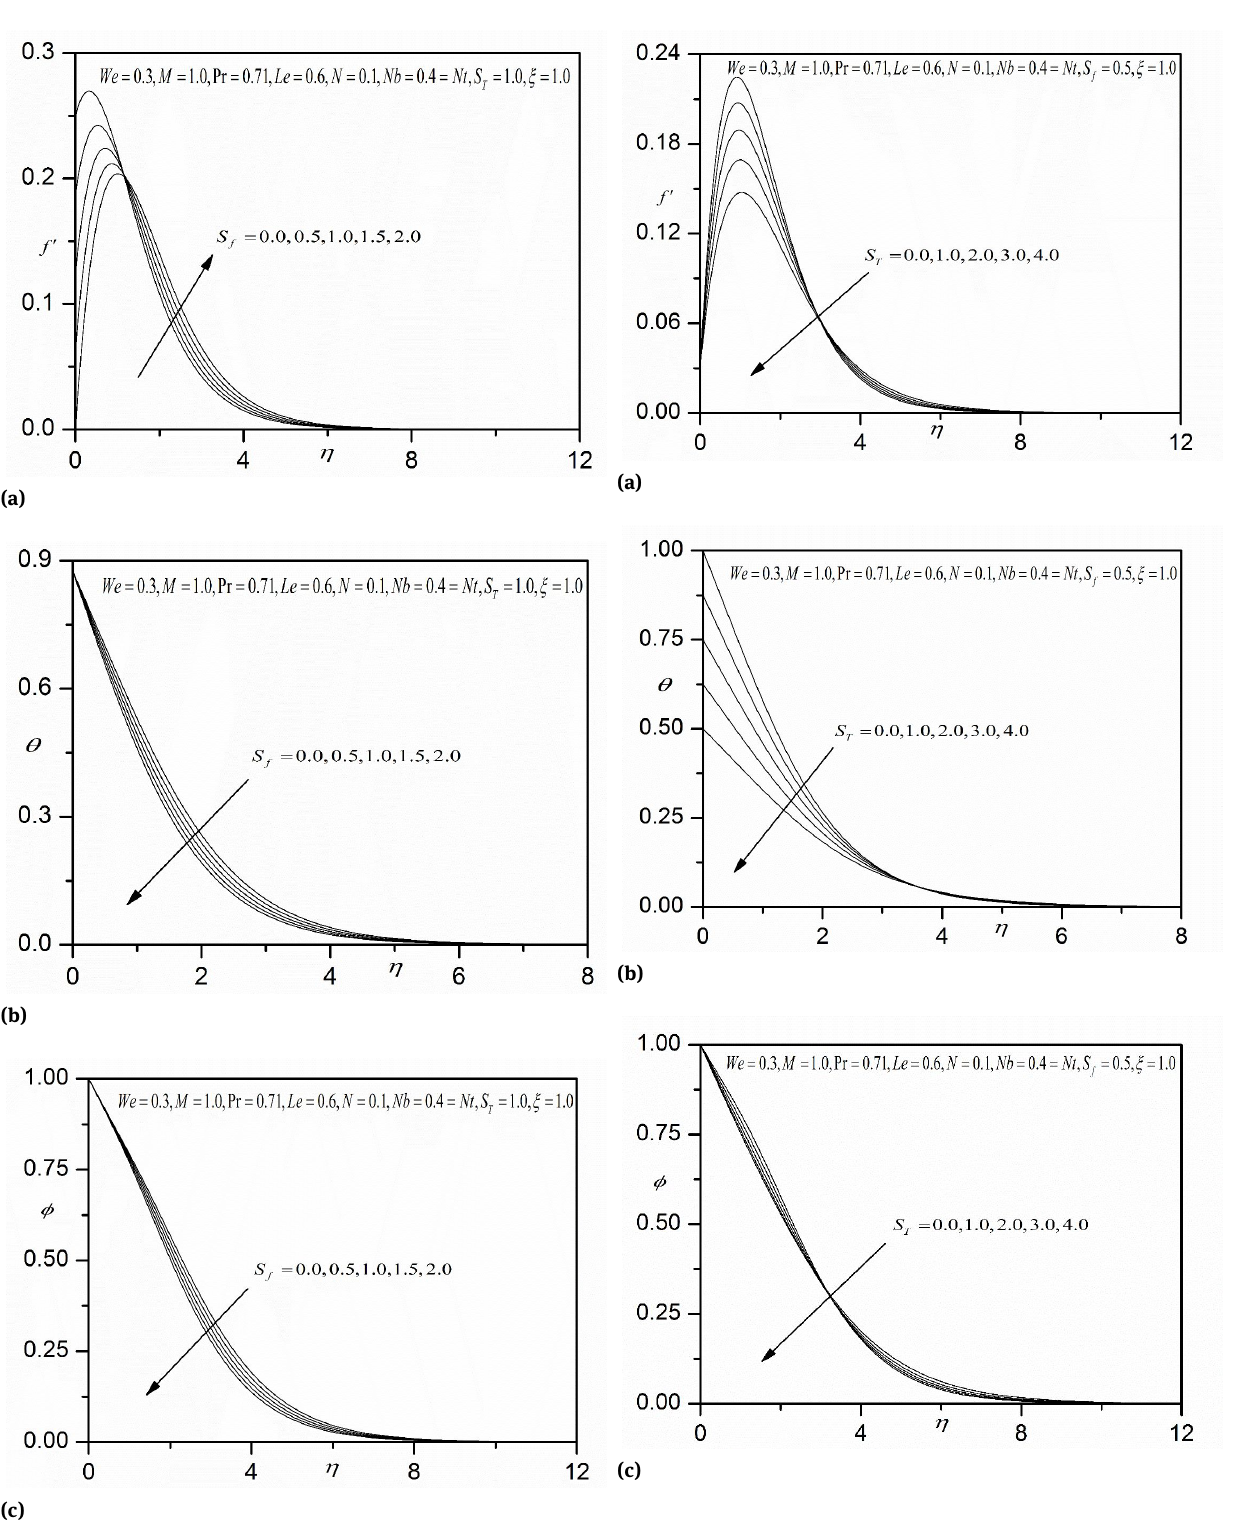
Fig. 7: (a) Effect of S T on velocity profile; (b) Effect of S T on tempera- ture profile; (c) Effect of S T on concentration